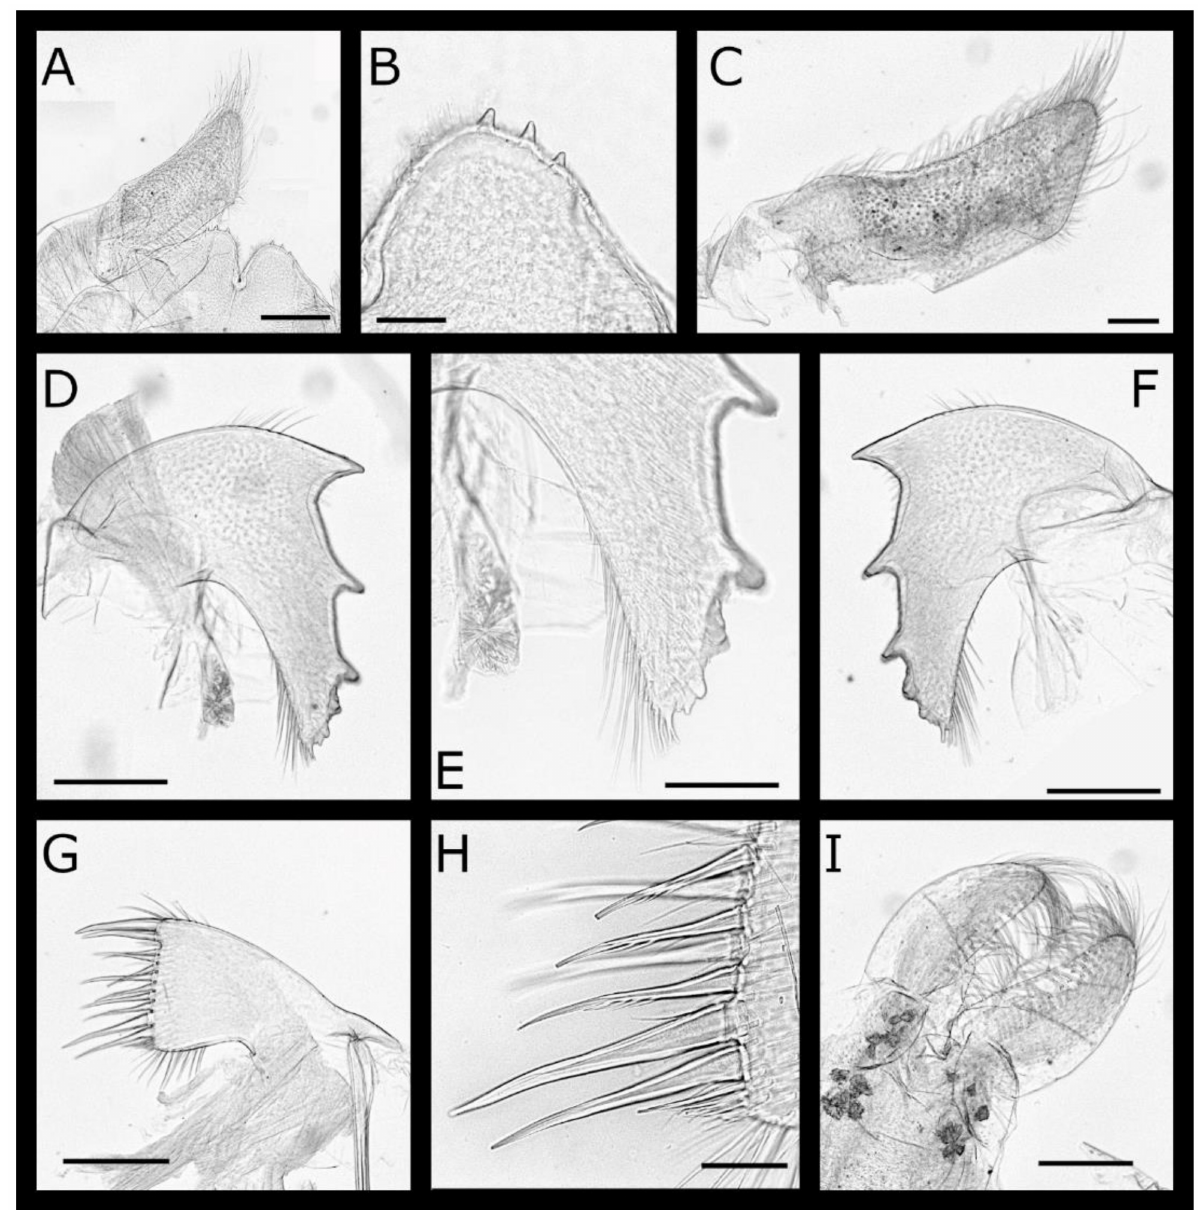
Figure 18. Pectinoacasta cancellorum (Hiro, 1931) mouthparts (WAM C55305): ( A ) labrum and right mandible palp; ( B ) close up of labrum crest; ( C ) left mandible palp; ( D ) left mandible; ( E ) closeup of inferior angle; ( F ) right mandible; ( G ) right maxillule; ( H ) close up of serrated setae of maxillule; ( I ) left and right maxilla. Scale bars: A, D, F, G, I = 200 µ m; B = 50 µ m; C = 100 µ